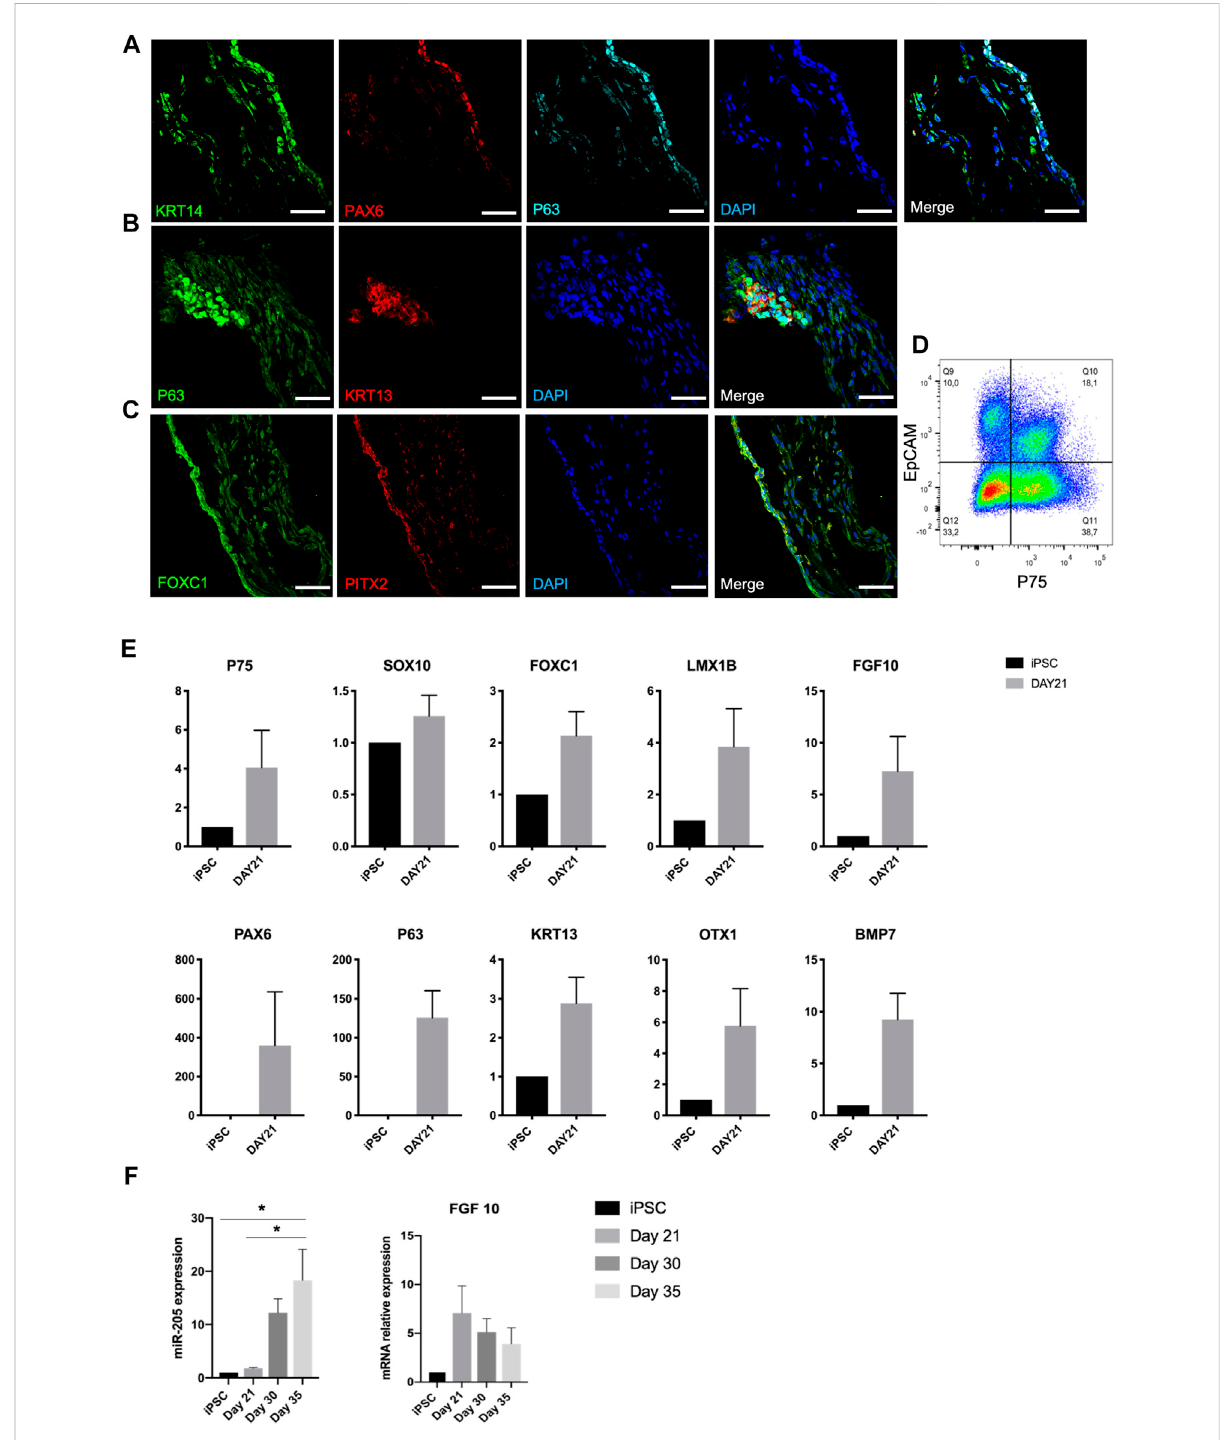
FIGURE 2 Expression of early lacrimal gland development markers in the protein and mRNA level on day 21 of differentiation con fi rms emergence of lacrimal gland stem and progenitor cells, (A) KRT14+/PAX6+/P63 + lacrimal gland multipotentepithelial stem cells, (B) KRT13+/P63 + lacrimal gland progenitor cells, (C) FOXC1+/PITX2+ periocular mesenchymal cells (Figures are representative of three independent differentiation experiments, scale bar: 50 µm), (D) Flow cytometry analysis of organoids with epithelial (EpCAM) and neural crest (P75) markers. N = 2 biological replicates. (E) Geneexpressionpro fi leoforganoids (F) miRNA205PCRexpressionandFGF10levelsduringthesametimecourse.(One-Way ANOVA.Errorbars represent standard error of mean. * p ≤ .05, n = 3 biological